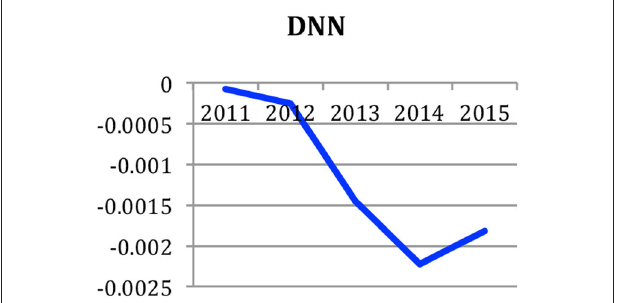
FIGURE 10 | Measure of the expectation of an emerging research topic: Deep Neural Networks (DNN).